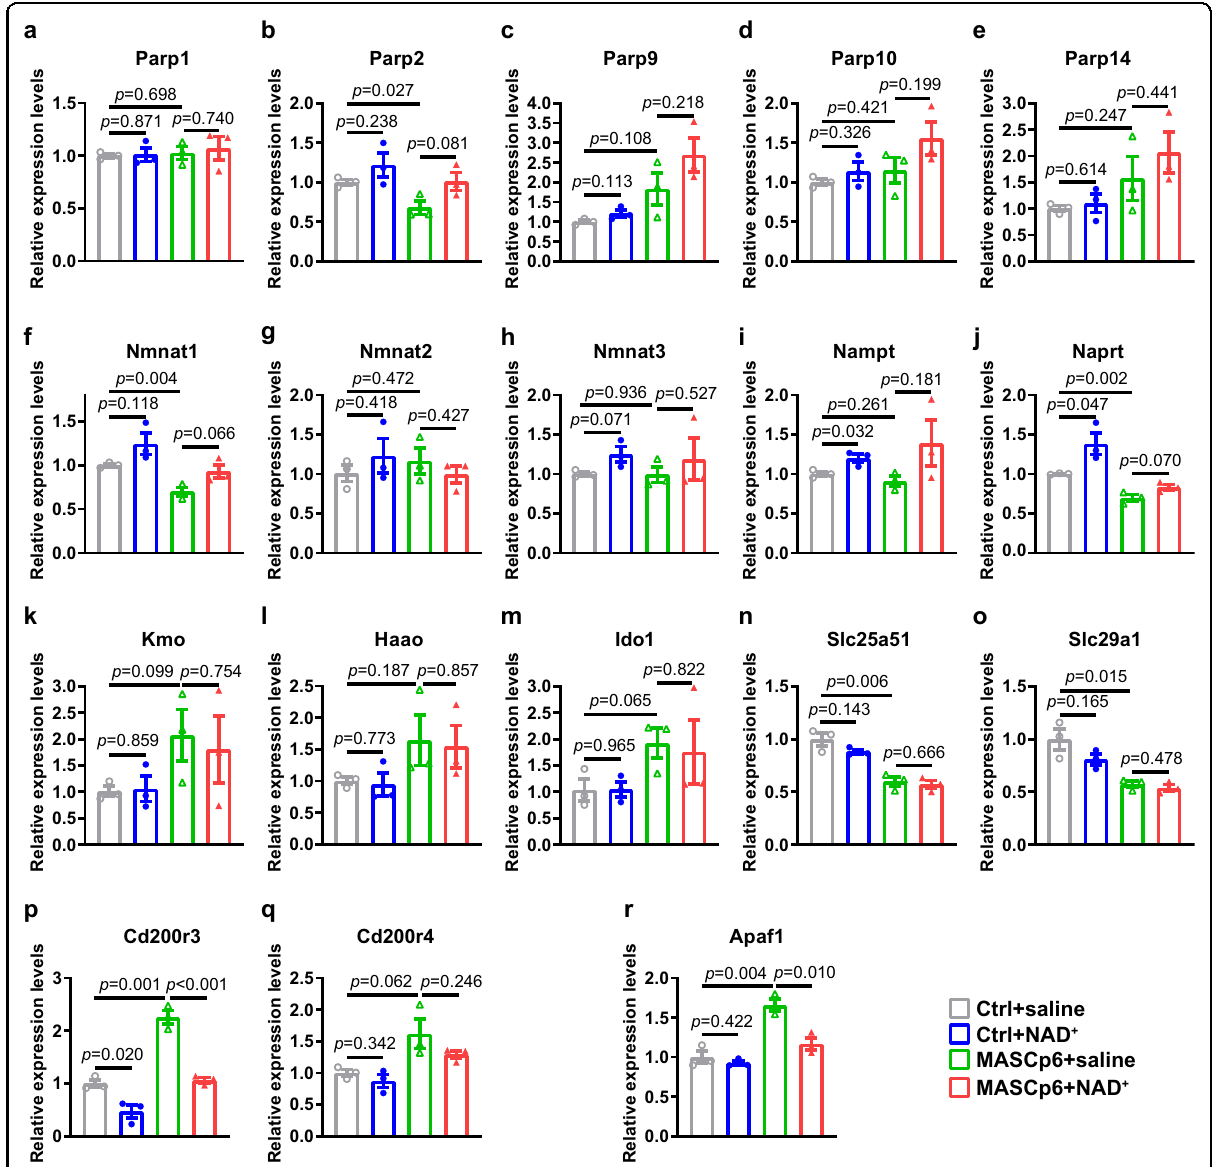
Fig. 5 Dysregulation of genes can be partially rescued by NAD + supplementation. a – e qPCR results of relative expression levels of PARP family members as listed. Parp1 ( a ), Parp2 ( b ), Parp9 ( c ), Parp10 ( d ), and Parp14 ( e ). f – j qPCR results of relative expression levels of NAD + salvage pathway- related genes, Nmnat1 ( f ), Nmnat2 ( g ), Nmnat3 ( h ), Nampt ( i ), and Naprt ( j ). k – o qPCR results of relative expression levels of three NAD + de novo synthesis-related genes, Haao ( k ), Ido1 ( l ), and Kmo ( m ), and two nucleoside transporter genes, Slc25a51 ( n ) and Slc29a1 ( o ). p , q qPCR results of relative expression levels of CD400 receptor genes, Cd200r3 ( p ) and Cd200r4 ( q ). r qPCR results of relative expression levels of apoptosis protease activating factor gene, Apaf1 . All quanti fi cation data are shown as means ± SEM, t -test. n = 3 mice for each group. Exact P values are